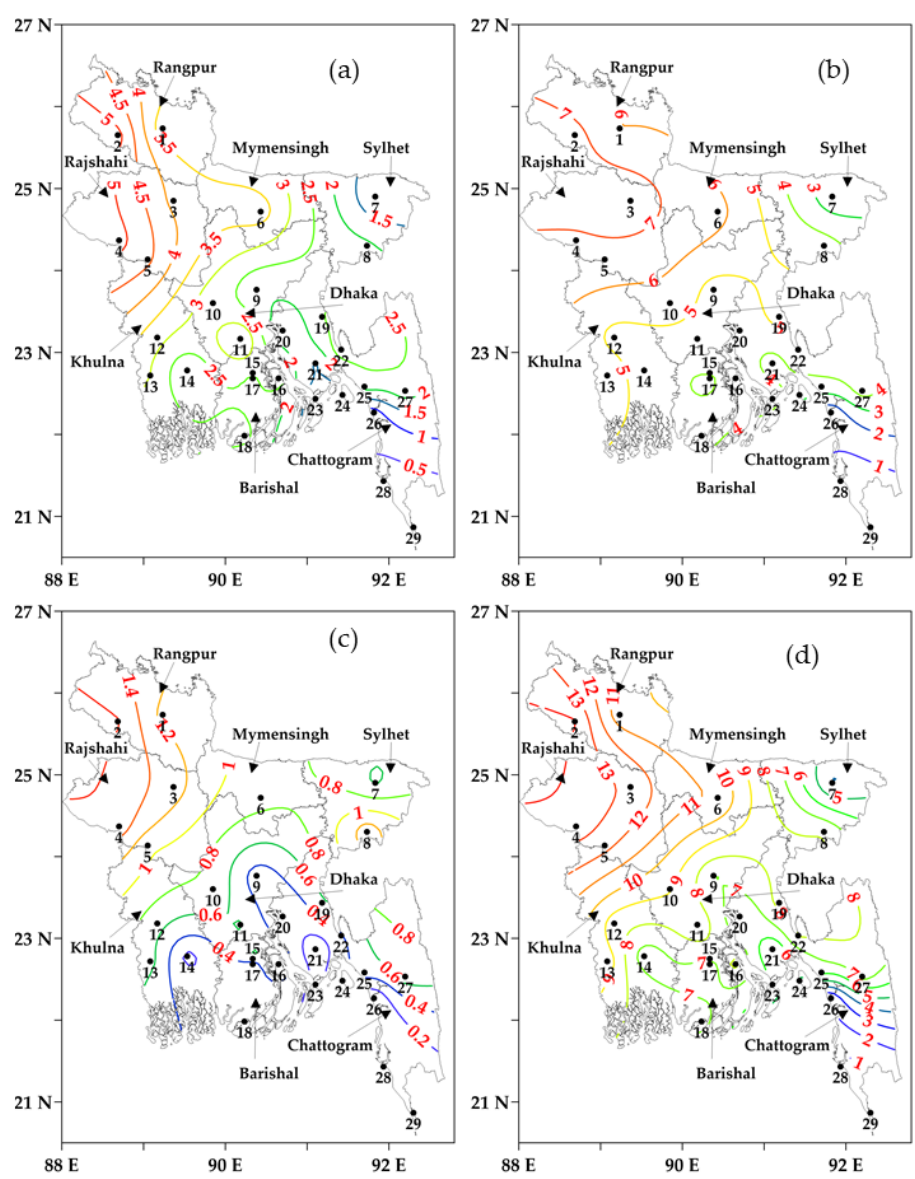
Figure 4. Calculation of the station-wise average cold days (in coloured contour lines with values) using the threshold of average temperatures, ( a ) December, ( b ) January, ( c ) February, and ( d ) the winter season during 2000‒2001 to 2020‒2021. The black numbers are the IDs of meteorological stations.